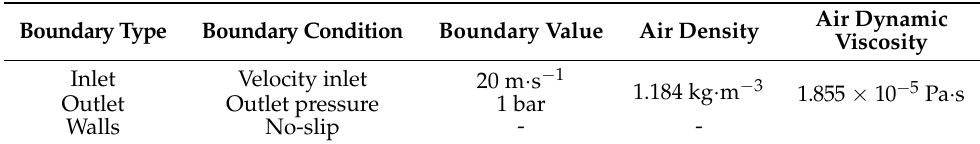
Table 1. The boundary conditions of the validation